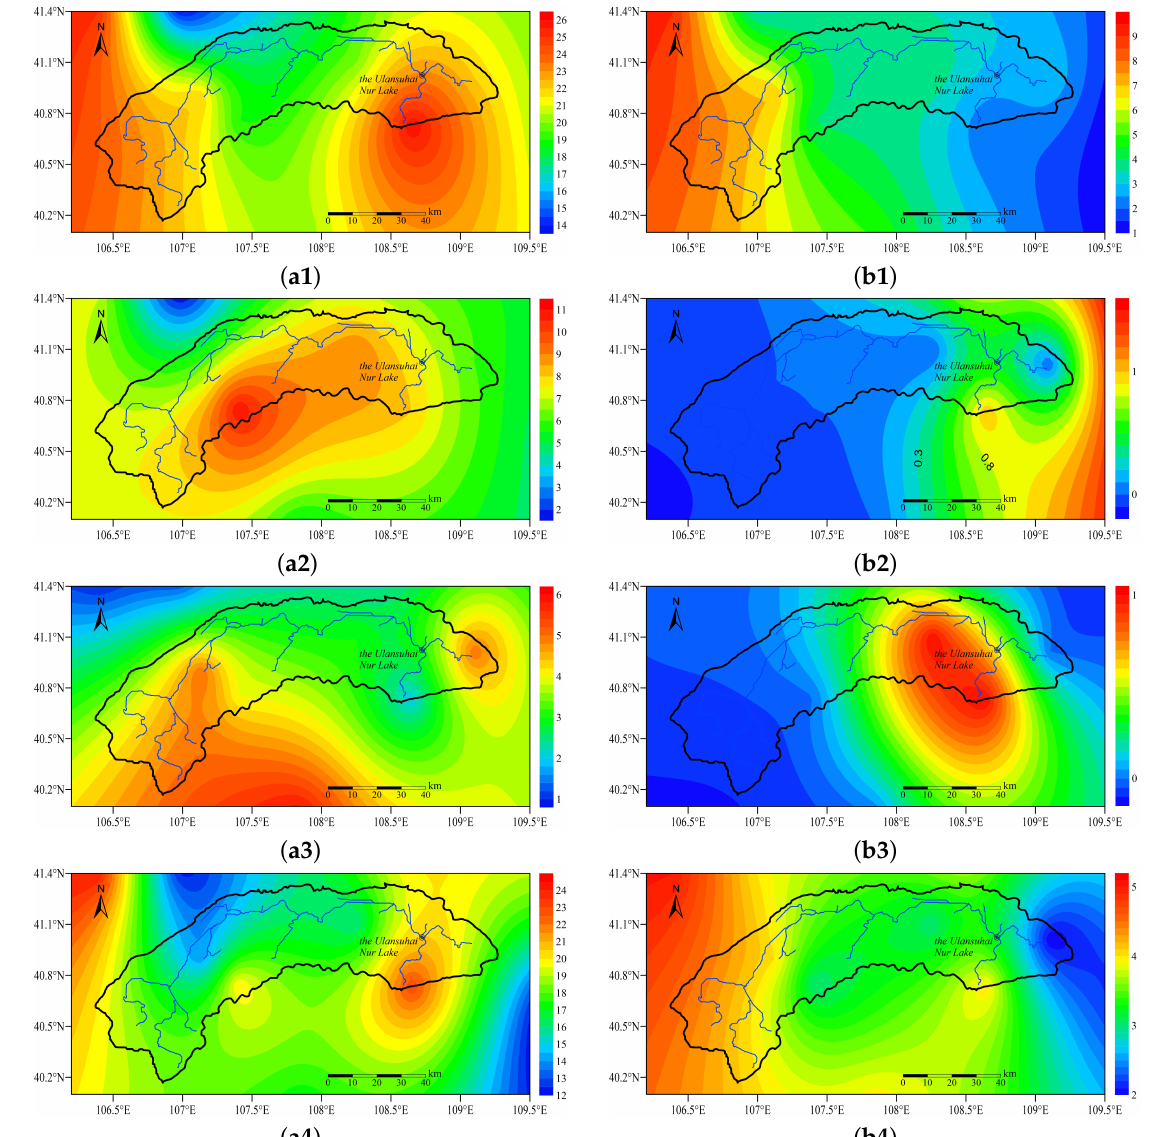
Figure 5. Spatial distribution of the frequency of flood-drought abrupt alternation events in the Hetao Area. ( a1 ) Flood-to-drought from May to July in 1961–2017; ( b1 ) Flood-to-drought from May to July in 2018–2050; ( a2 ) Drought-to-flood from May to July in 1961–2017; ( b2 ) Drought-to-flood from May to July in 2018–2050; ( a3 ) Flood-to-drought from July to September in 1961–2017; ( b3 ) Flood-to-drought from July to September in 2018–2050; ( a4 ) Drought-to-flood from July to September in 1961–2017; ( b4 ) Drought-to-flood from July to September in